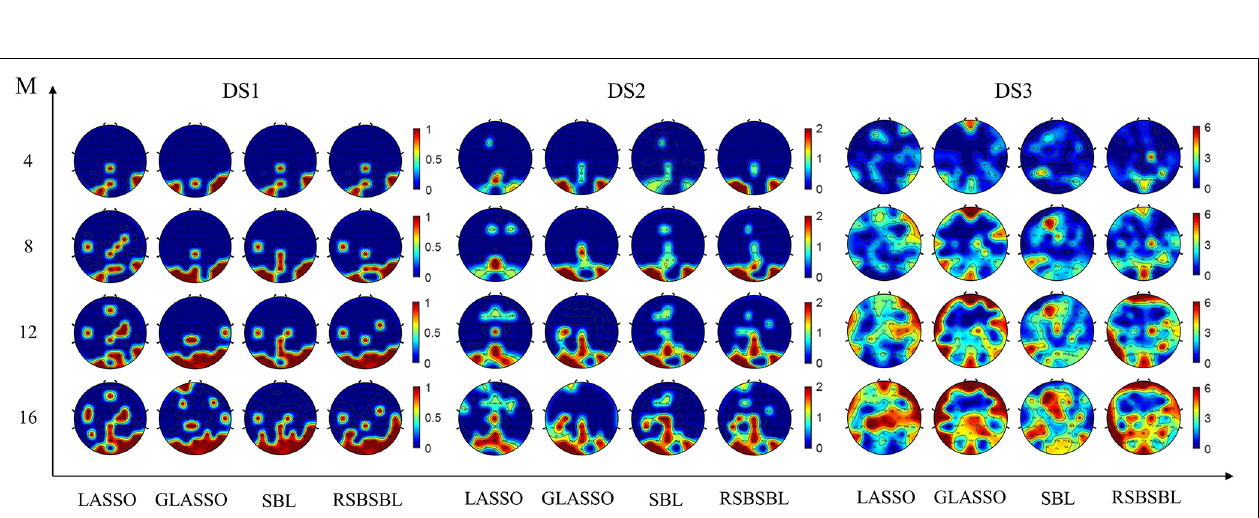
FIGURE 5 | The scalp distribution of the four methods on DS1, DS2, and DS3 when M channels are selected. The contribution value of each channel is equal to the sum of the selected numbers among all participants in the dataset. The color changes from red to blue, indicating that the channel is selected less